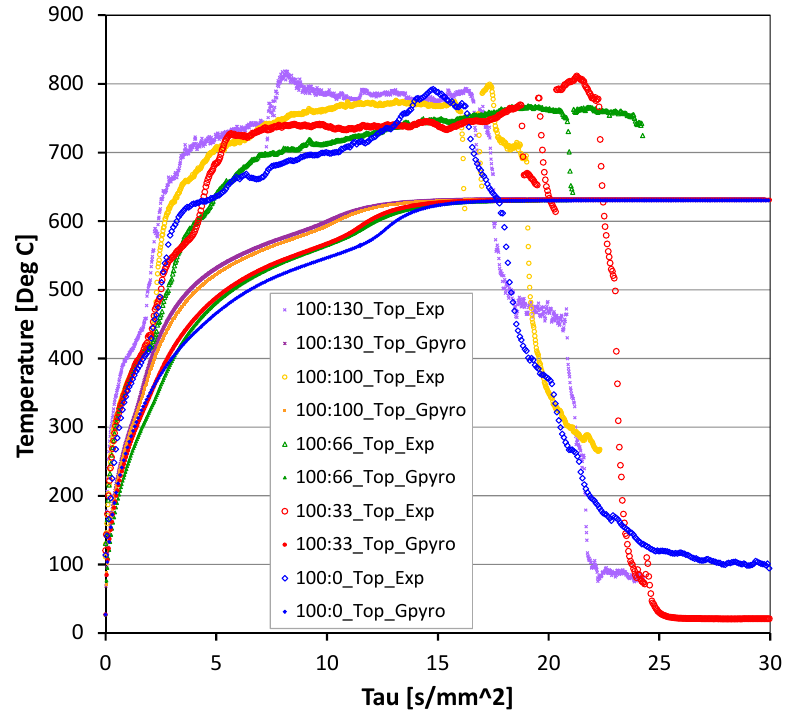
Figure 8. Experimental and simulated exposed face temperatures (Tau is the time divided by sample thickness squared).